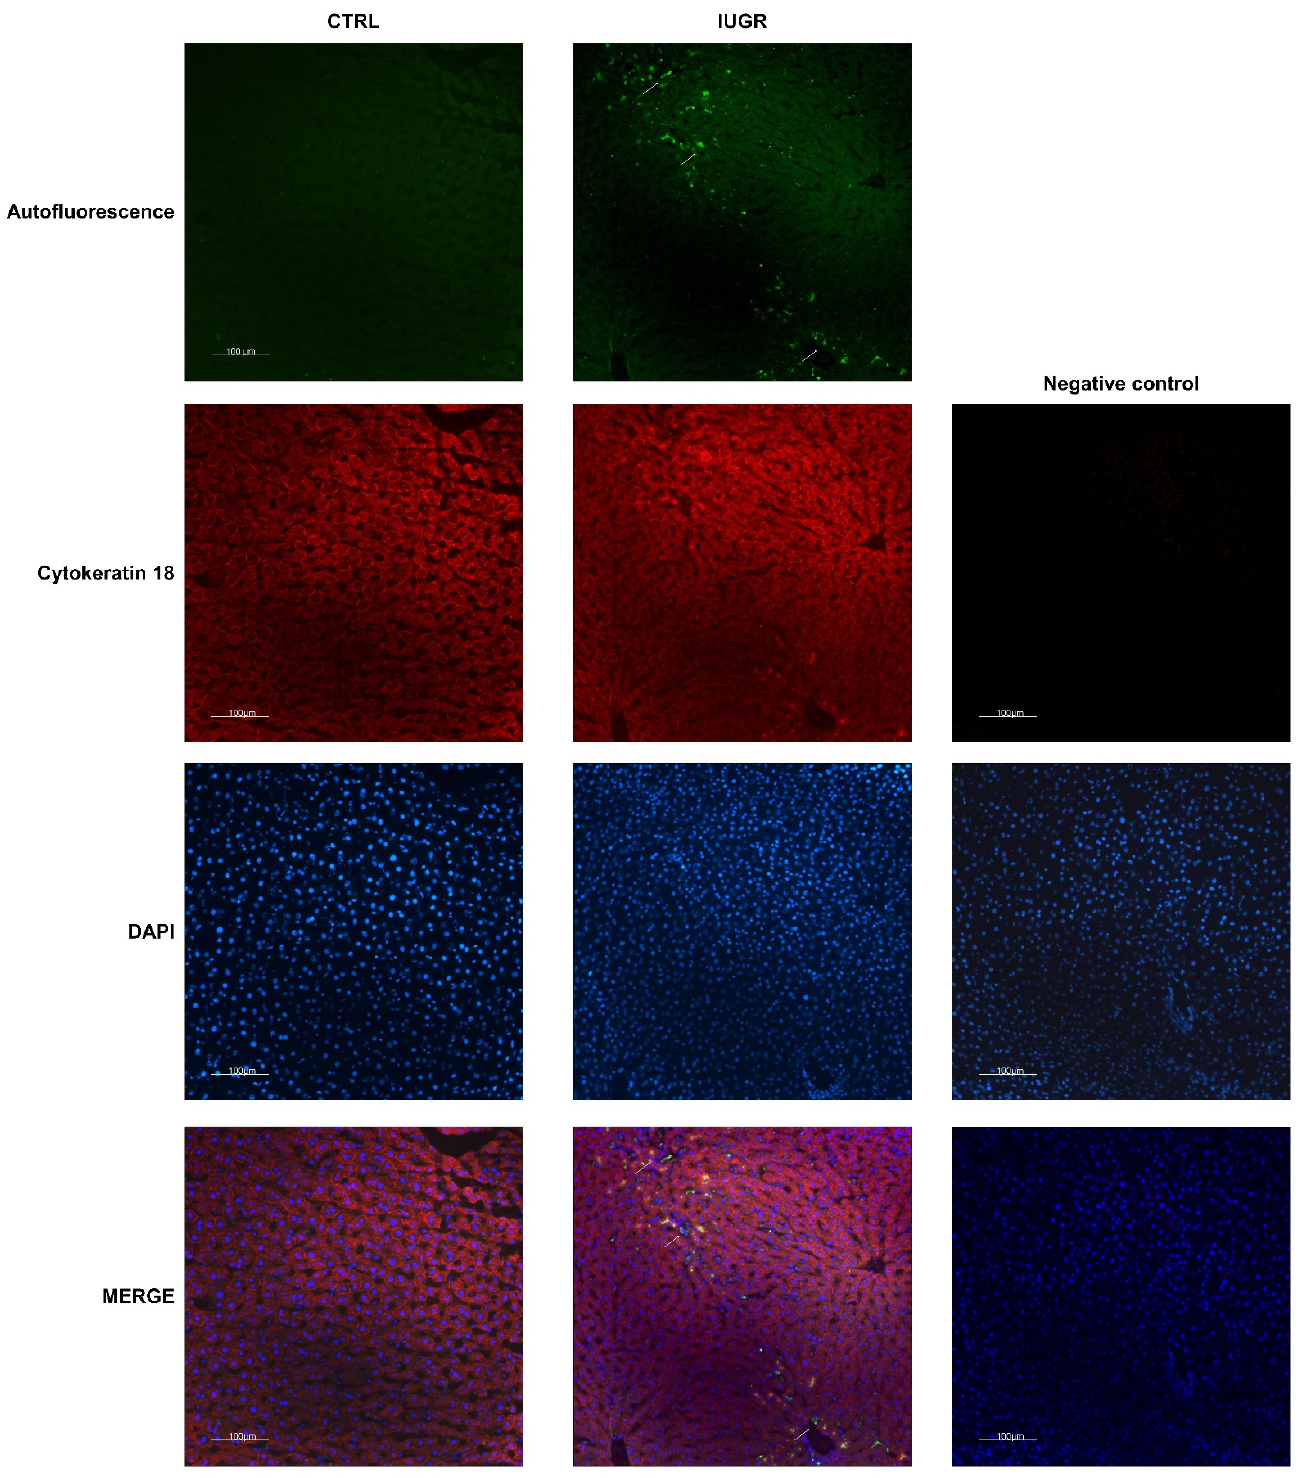
Figure 11. Lipofuscin localization in CTRL and IUGR male livers at 6 months of age. Lipofuscin detection was performed using autofluorescence (GFP filter), and hepatocytes were identified using cytokeratin-18 staining. Lipofuscin deposits are indicated by arrows. A negative control was established. Nuclei were counterstained with DAPI. n = 5 animals/group. Magnification (20×). Scale bar = 100 µm.